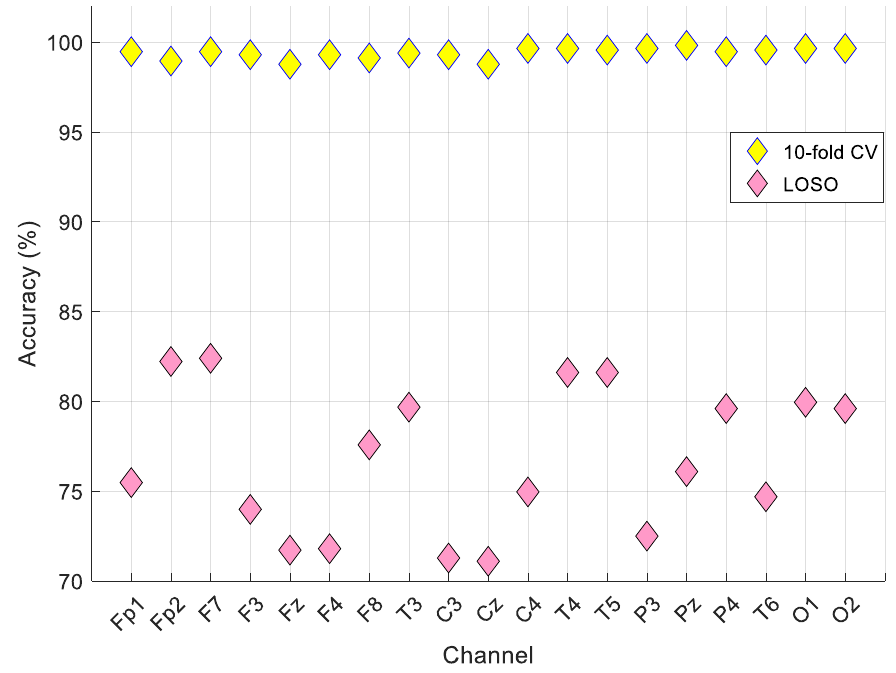
Figure 6. The obtained comparative results according to the validation technique.